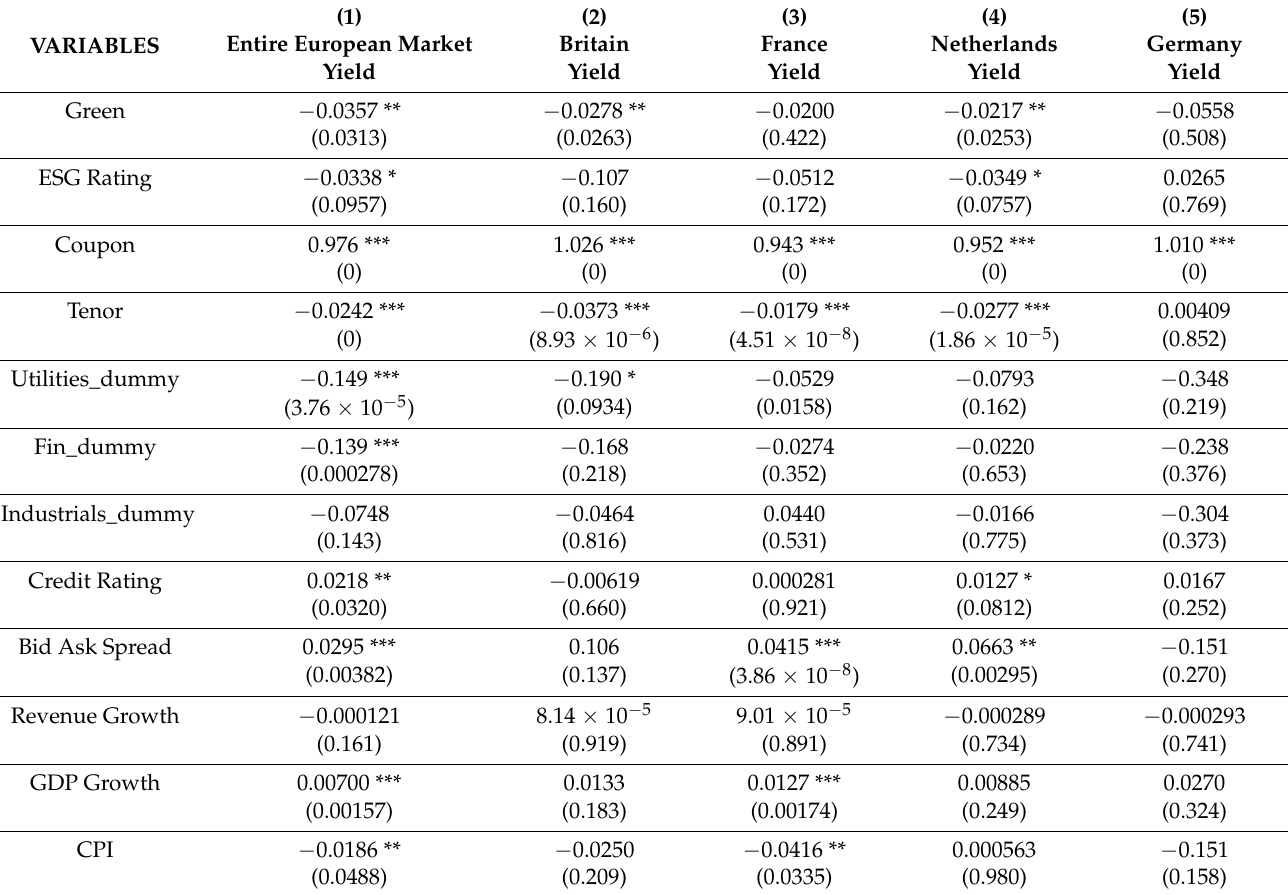
Table 4. The results of model (1)